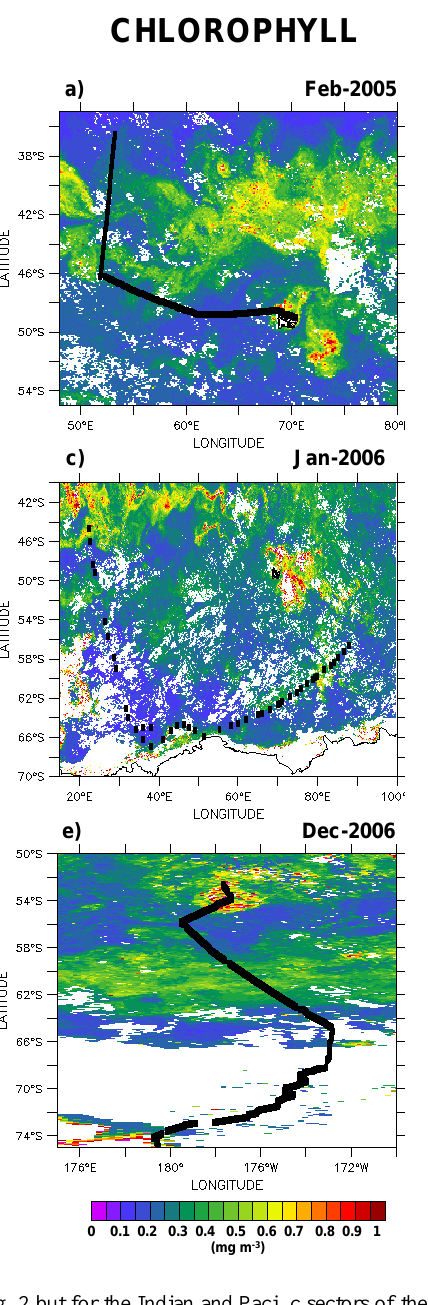
Fig. 4. Same as Fig. 2 but for the Indian and Pacific sectors of the Southern Ocean. (a, b, c, d) Indian sector of the Southern Ocean, (e, f) Pacific sector of the Southern